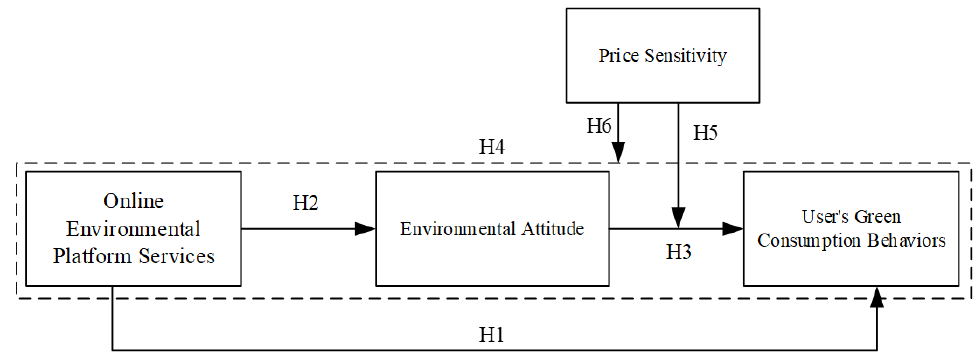
Figure 1. Hypotheses and analytical framework.